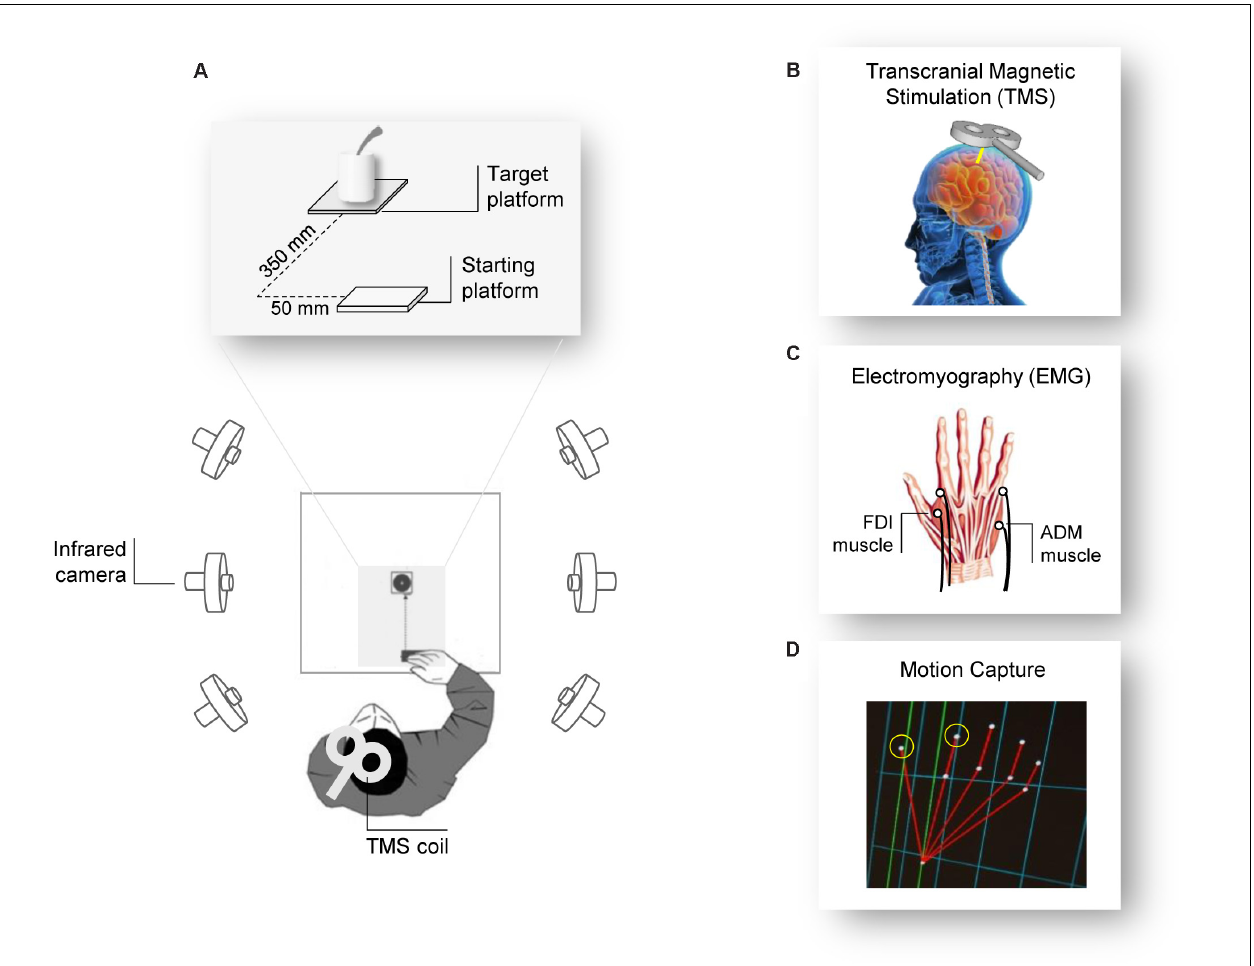
FIGURE 1 | Experiment setup. (A) The participants were seated in front of a table surrounded by six infrared cameras. The participant’s hand was positioned in front of the object they had to grasp after the Go signal (TMS pulse). (B) The TMS coil was placed over the participant’s left M1 and (C) MEPs and EMG activity were measured from electrodes placed over the FDI and the ADM muscles of the right hand. (D) Two infrared reflective markers taped to the participant’s index and thumb fingers were used to track the right hand’s